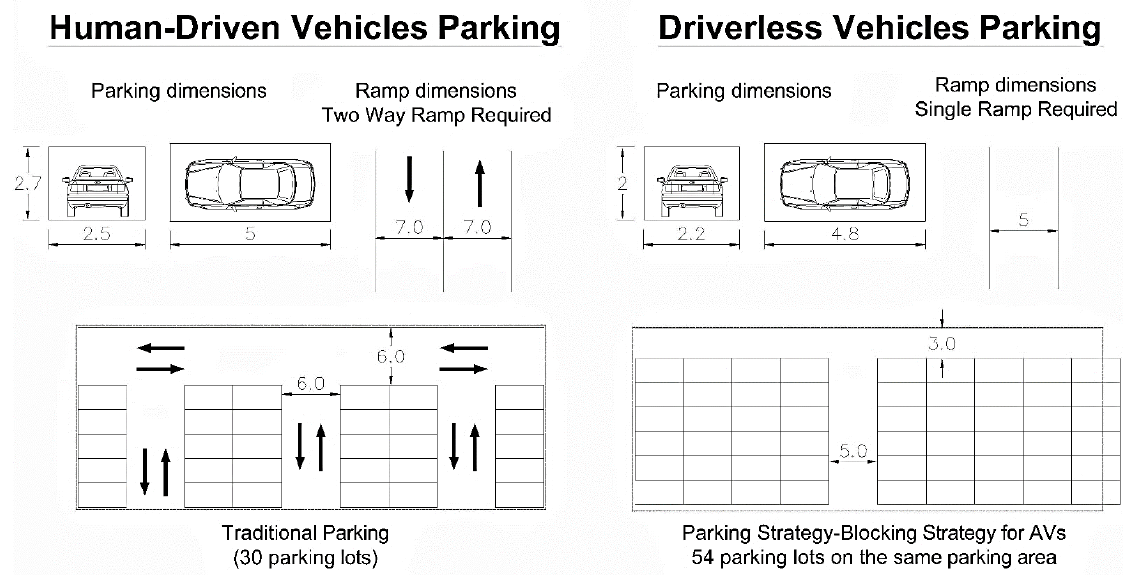
Figure 9. Parking Strategy for human-driven vehicles and AVs. ( left ) Conventional parking layout; ( right ) Autonomous parking layout (adopted from [68]).